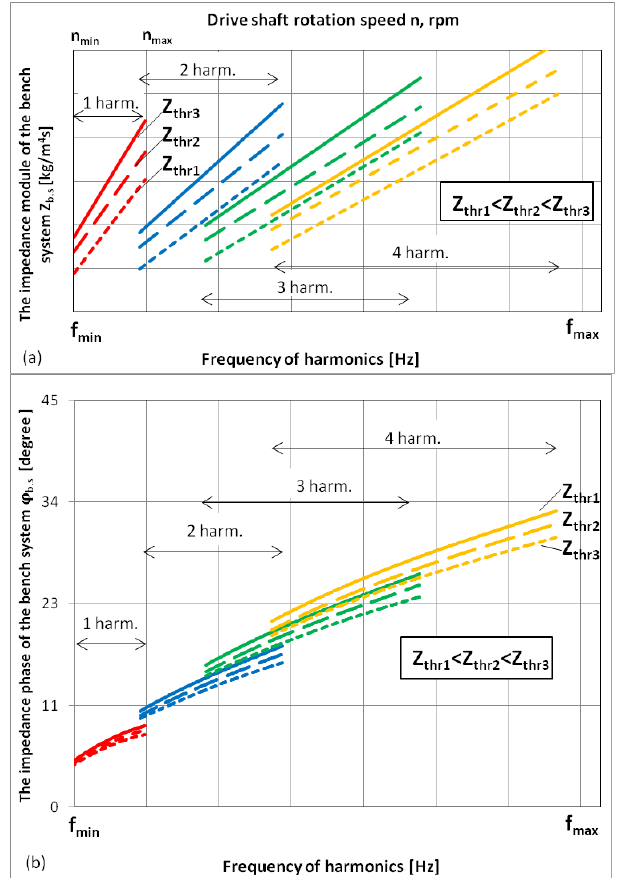
Figure 12. Bench system impedance with a throttle at the pump outlet: ( a ) impedance module and ( b ) impedance phase. Figure 13. ISO 1219 scheme of the bench system implementing the inertial load impedance at the liquid output from the pump: 1—test pump; 2—line; 3—cavity of “infinite” volume; 4—load throttle; 5—flow sensor, 6 and 7—connecting fittings; 8 and 9—pressure sensors at the line input and in the cavity, respectively.